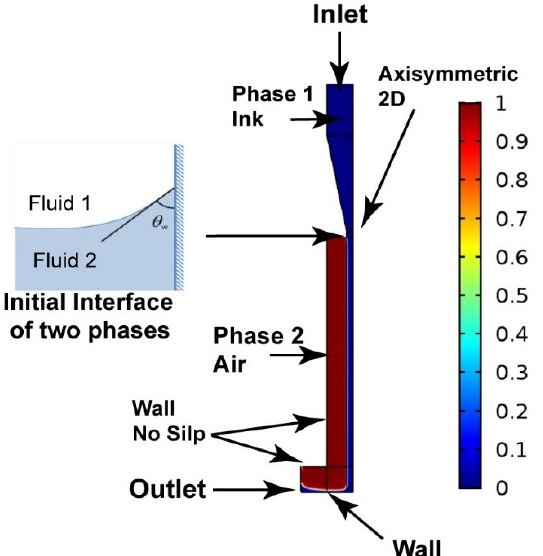
Figure 3. Schematic boundary condition representation for the numerical simulation of chitosan 3D printing.